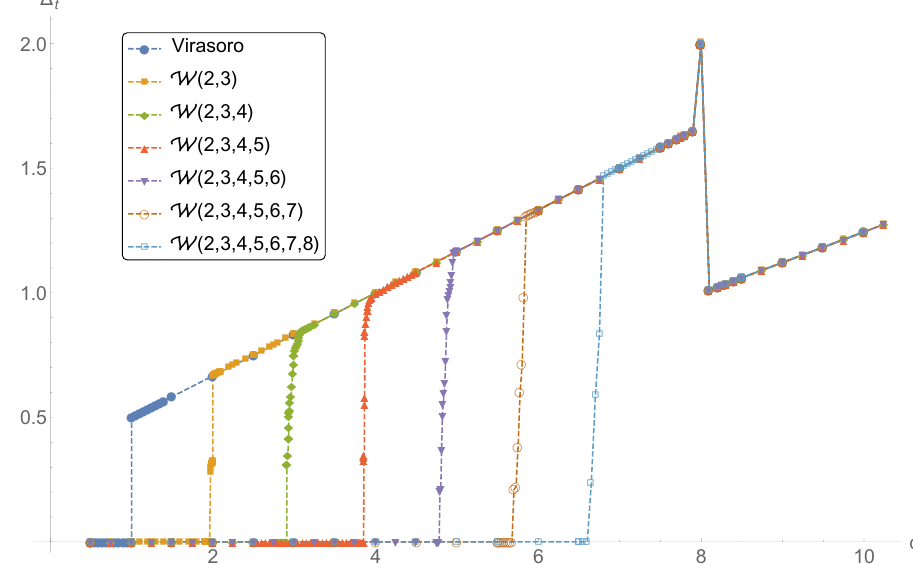
Figure 3. Numerical bounds on the twist gap with various W -algebras. We also assume the presence of the conserved currents of j (cid:21) 1 in the